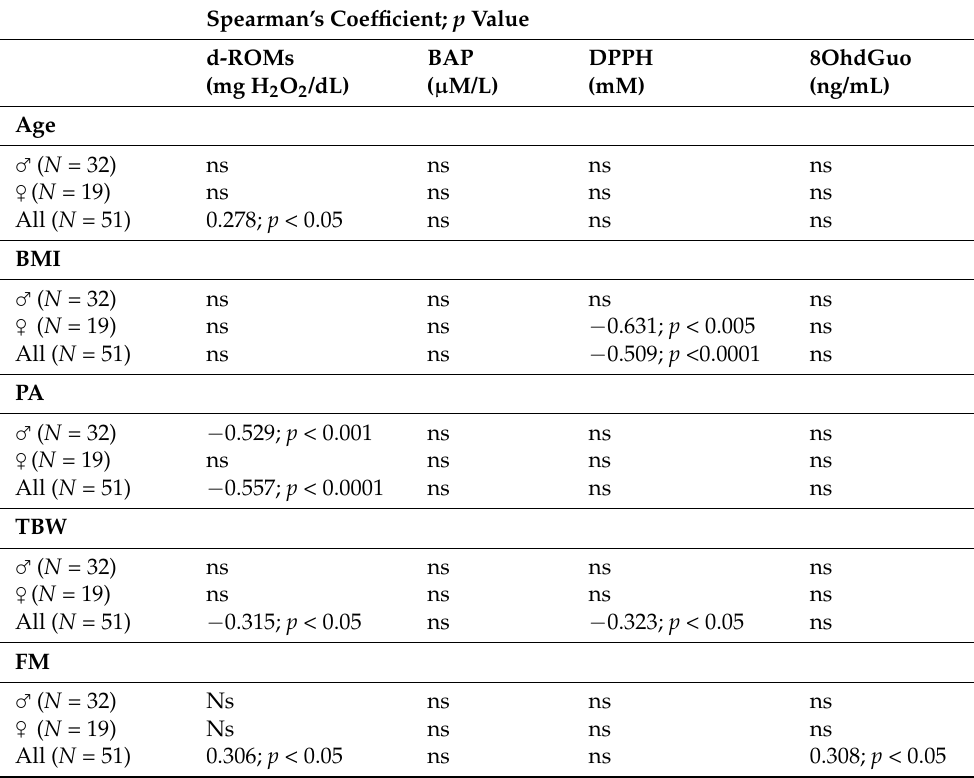
Table 3. Bivariate correlations between body features and OS parameters. Spearman’s Rho coefficients and p values are reported only for significant correlations (ns = not